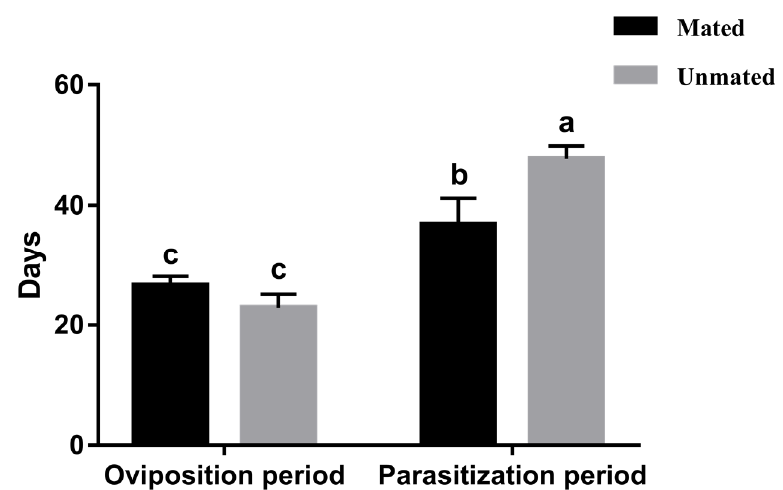
Figure 1. Oviposition and parasitization periods of mated and unmated T. drosophilae females. Bars refer to mean ± SE and different letters above the bars indicate significant differences (Tukey’s HSD, p < 0.05).